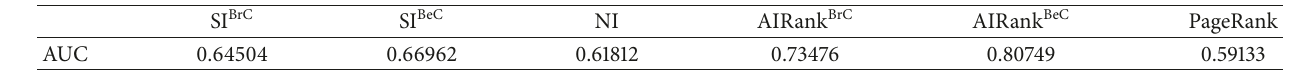
Table 3: AUC of each method.